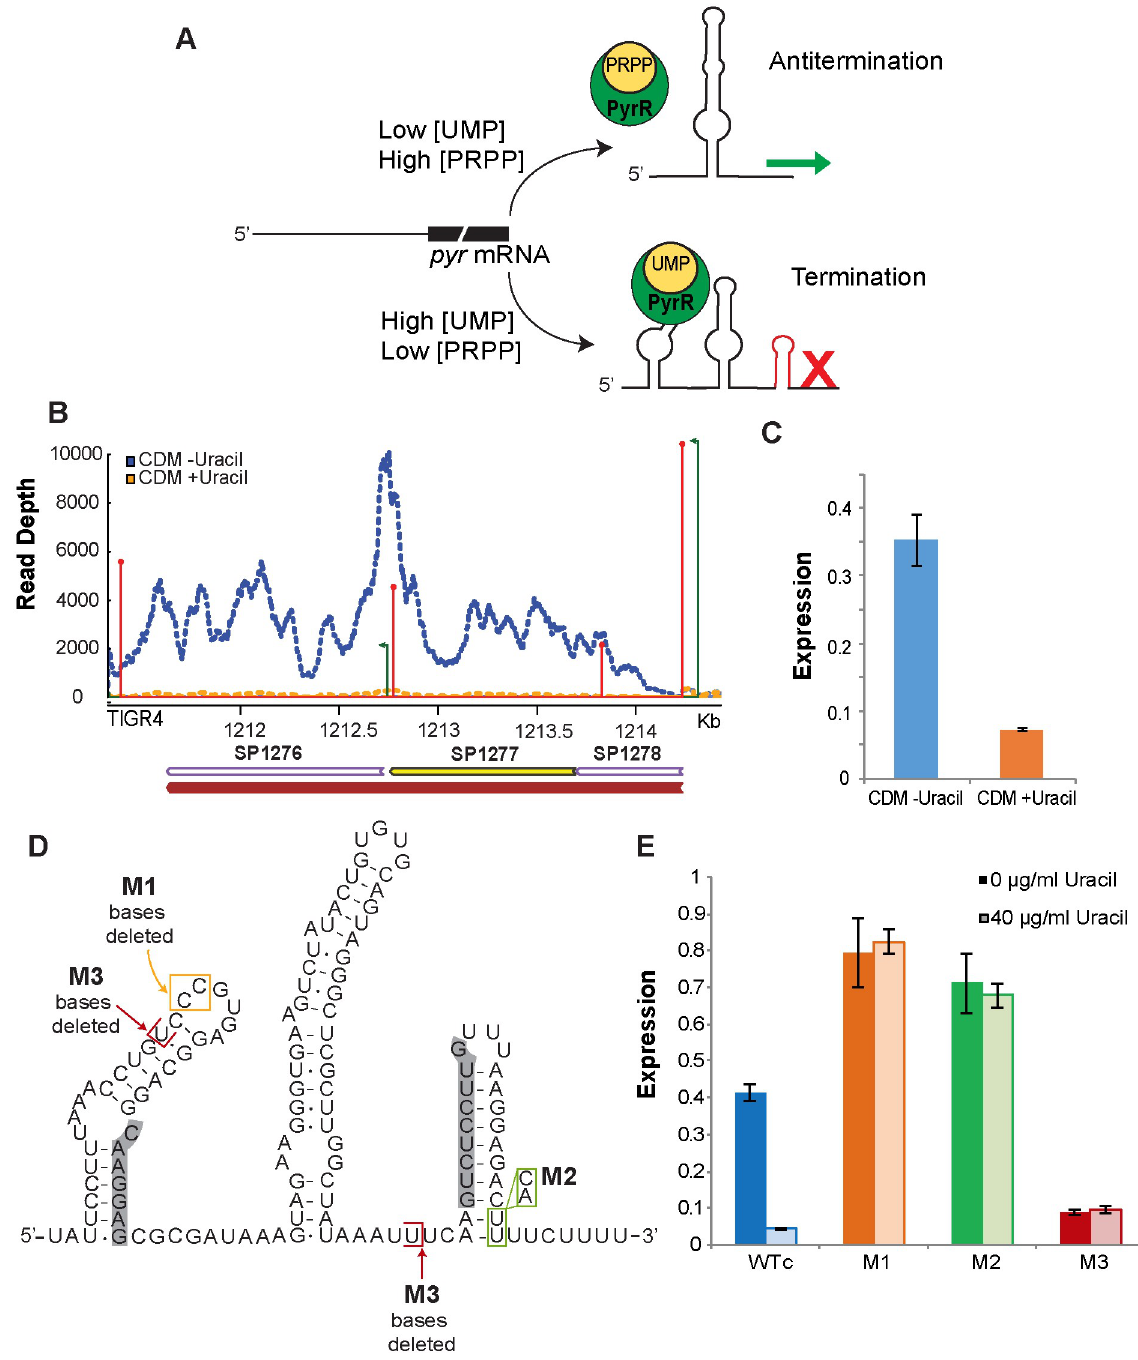
Fig 6. Mechanism, structure and regulatory activity of pyrR regulatory RNA element and its mutants in the presence and absence of uracil. ( A) Schematic representation of the proposed mechanism of regulation of pyr operon by pyrR RNA element. In the presence of UMP, PyrR binds to the pyrR RNA and results in the formation of a premature terminator, disrupting the anti-terminator formed when UMP is low, resulting in transcription termination. (B) RNA-Seq coverage map across the pyr operon (SP_1278–1276) showing premature transcription termination and consequently decreased expression of its genes downstream of the pyrR regulator when grown in defined medium (CDM) in the presence of uracil (yellow) compared to the absence of uracil (blue). Coverage was normalized to the number of uniquely mapped reads in each library. TSSs are in green and the size represents the log transformation of the processed/unprocessed ratio and TTSs are in red and size represents the log transformation of the coverage. (C) qRT-PCR determining the expression of the first genes in the pyr operon (SP_1278) in the presence and absence of uracil validates the RNA-Seq observation. Expression is relative to the qPCR internal control. ( D) Secondary